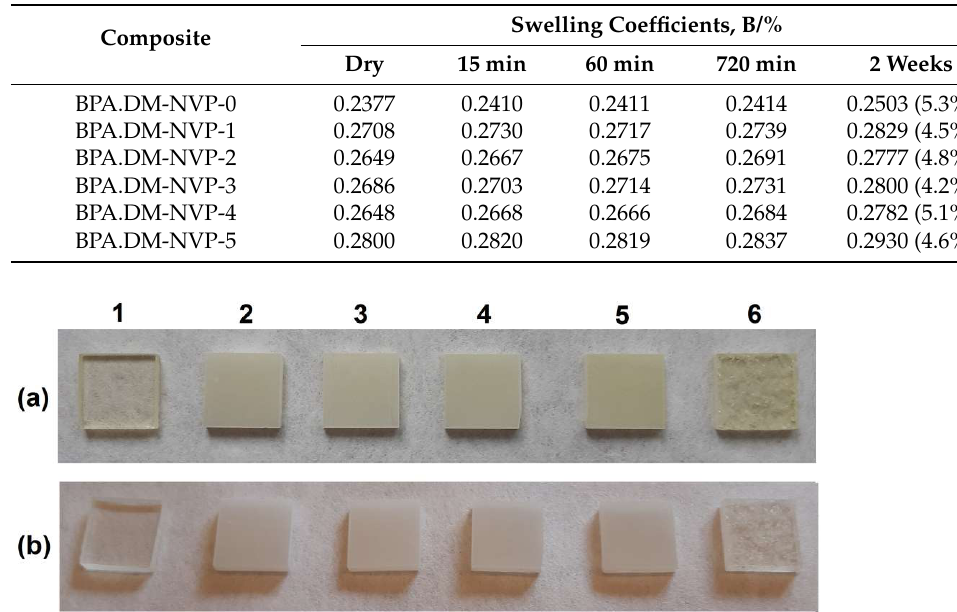
Figure 7. Photos of the samples after cutting (10 mm × 10 mm) for the swelling measurements: before swelling ( a ) and after swelling ( b ) in water (numbers of the sample according to Table 1). Table 2. Swelling studies results.